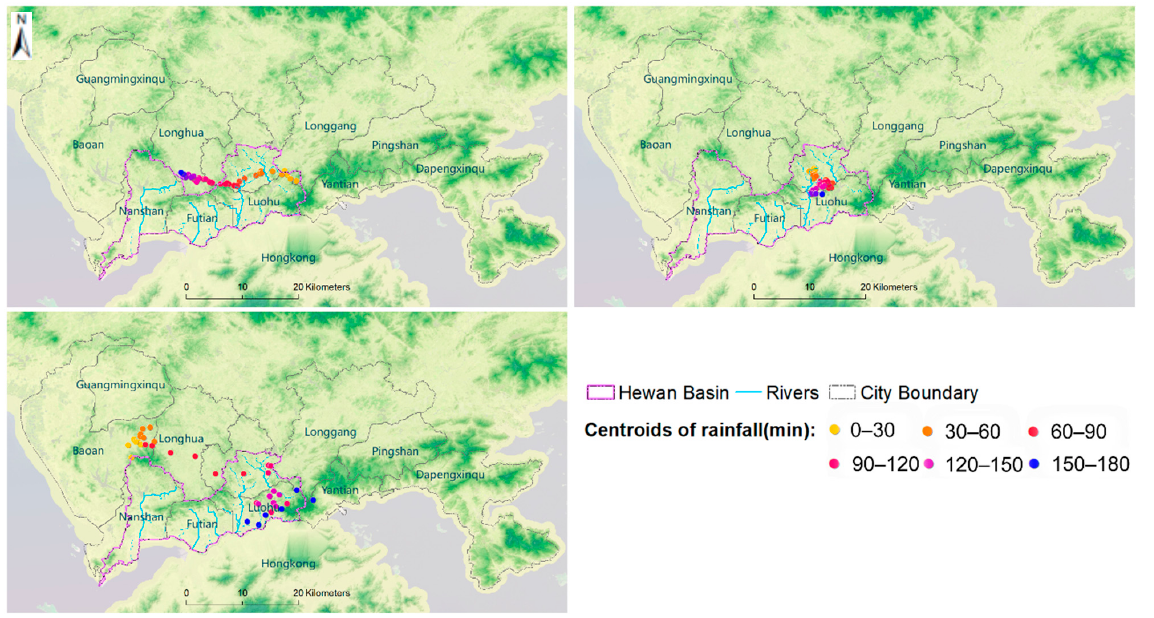
Figure 2. Distribution map of rainstorm center points in various rainfall periods.